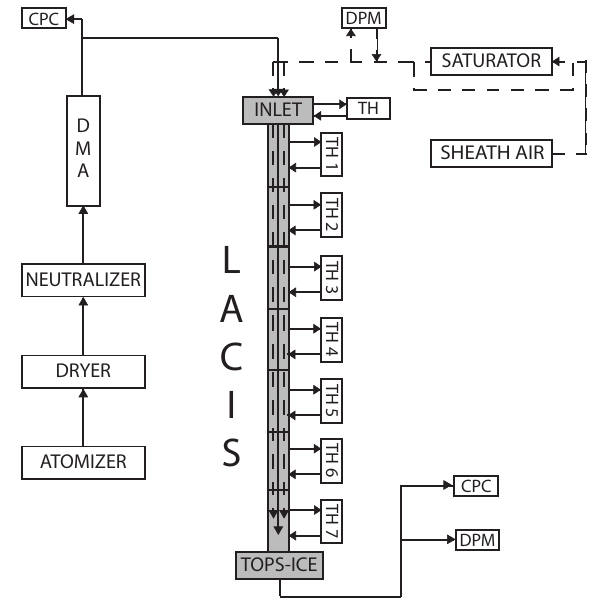
Fig. 1. Setup of the particle generation, the LACIS flow tube and op- tical detection system. The abbreviations stand for: DMA – Differ- ential Mobility Analyser, DPM – chilled mirror dew point hygrome- ter, TH – thermostat, TOPS-Ice – Thermally Stabilized Optical Par- ticle Spectrometer, and CPC – condensational particle